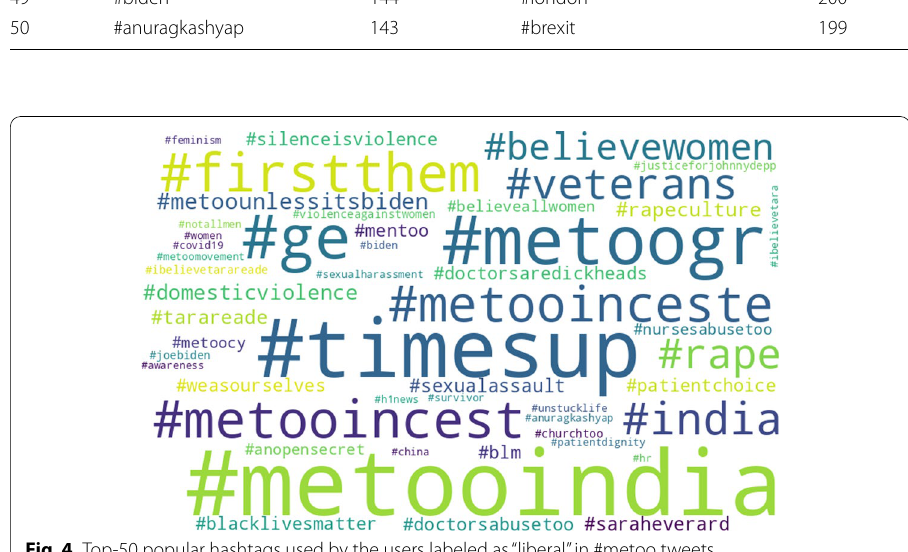
Fig. 4 Top‑50 popular hashtags used by the users labeled as “liberal” in #metoo tweets